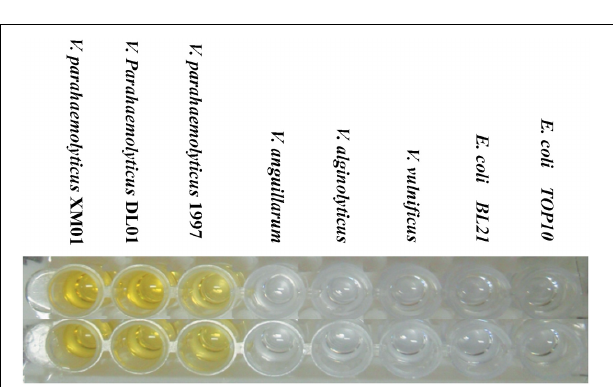
FIGURE 6 | ELISA Detection of TLH in Bacteria. Eight different bacterial strains (three TLH positive V. parahaemolyticus strains, three TLH negative Vibrio strains and two other E. coli strains) were cultured in APW medium without shaking for 16h, and the supernatant of culture was used to coat the 96 wells plate at 4 ◦ C for overnight. The ELISA assay was determined using an anti 6 × His tag antibody. (PC, positive control; NC, negative